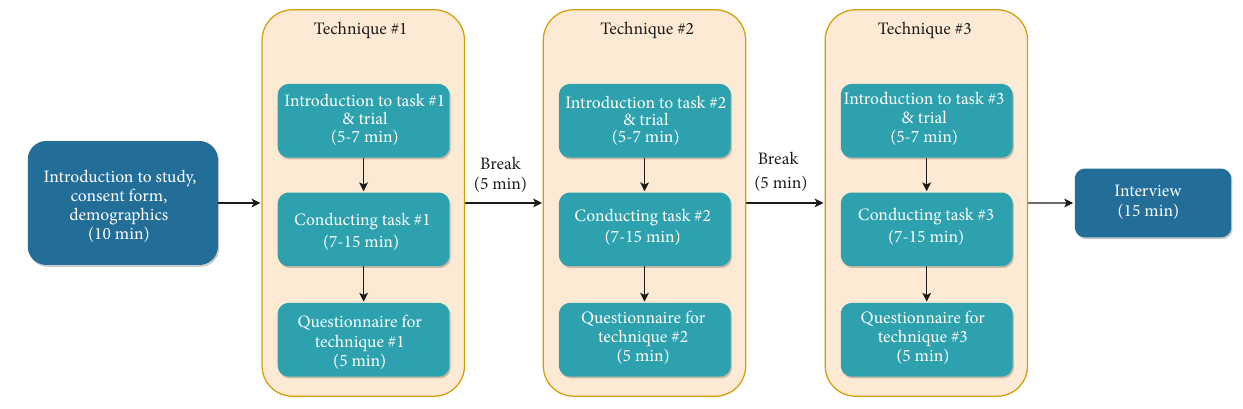
Figure 6: The procedure of the study. Table 1: Summary of the pair-wise comparisons from the Wilcoxon signed rank tests. GEQ